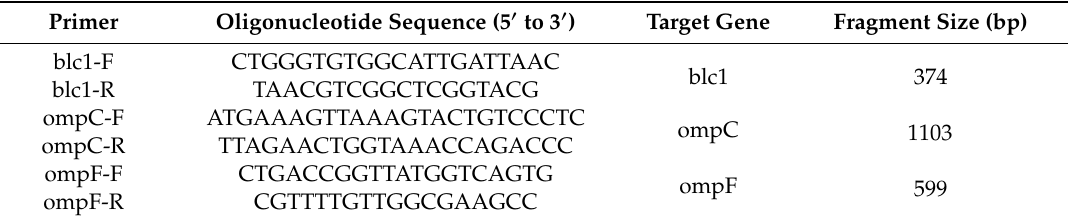
Table 2. Oligonucleotide sequence of primers and PCR product